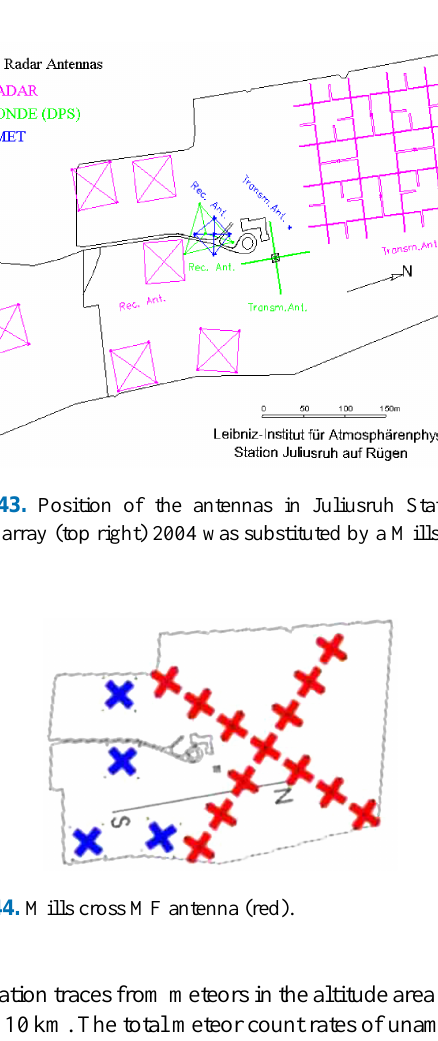
by ionisation traces from meteors in the altitude area between 80 and 110 km. The total meteor count rates of unambiguous detections vary throughout the year between 100 and 500 me- teors per hour.